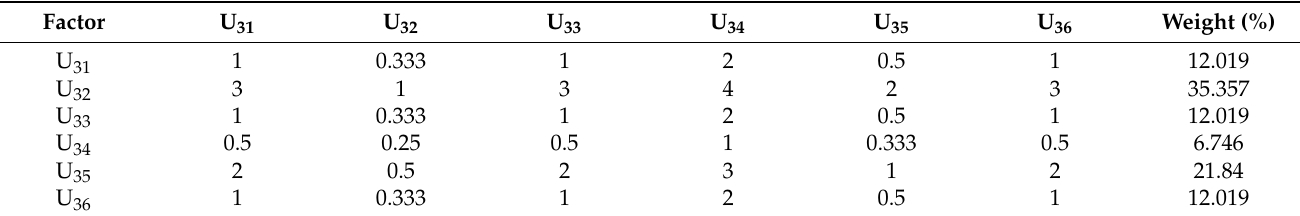
Table 7. Judgment matrix of SZSOJ’s second-level evaluation factors (U 3 ).